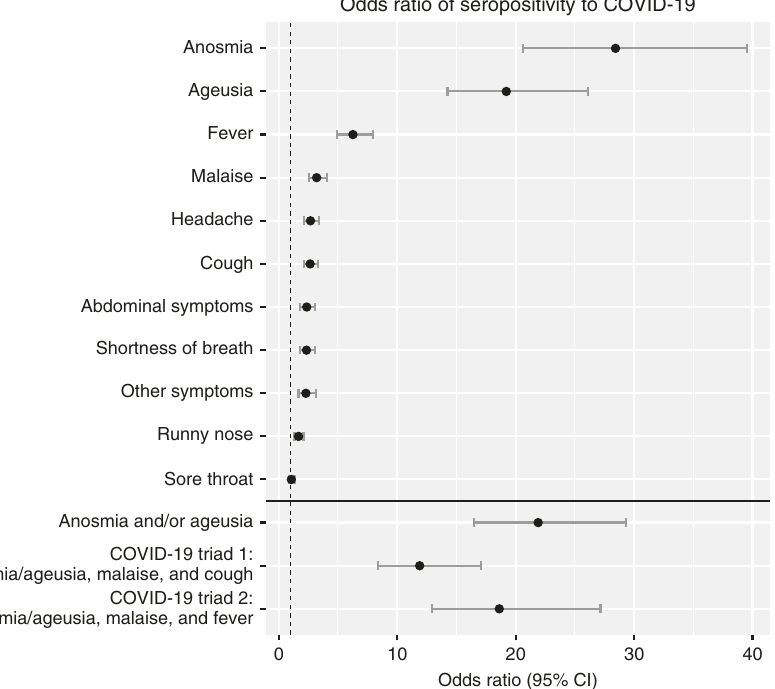
Fig. 2 Associations between prior symptoms and seroprevalence of SARS-CoV 2 IgG antibodies. Odds ratios of seropositivity for individually reported symptoms. Odds ratios were calculated using two-sided Fisher ’ s exact test with n = 2149 independent individuals. No adjustment for multiple comparisons was applied. Data are presented as odds ratios and 95% con fi dence intervals. Source data are available as Source Data fi le.